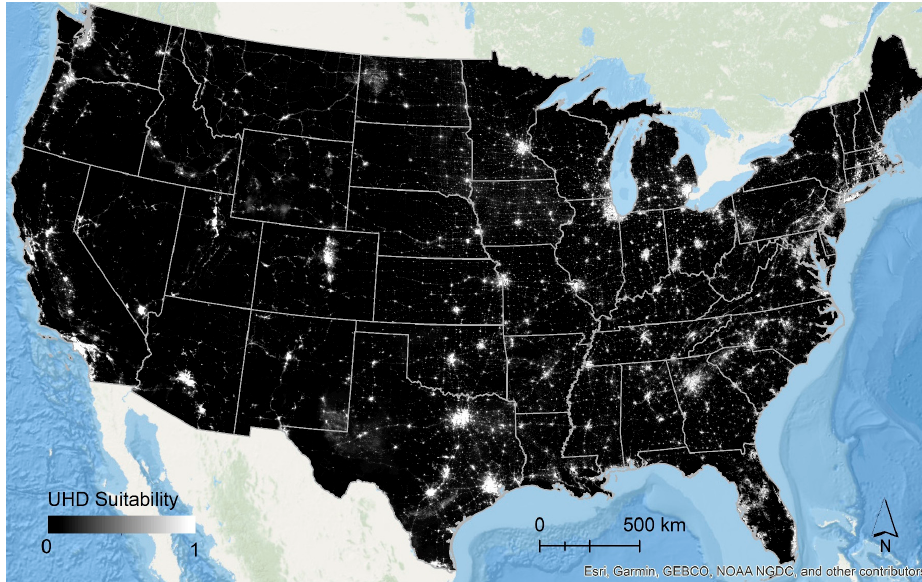
Figure 3. Overview of urban and highly developed (UHD) suitability. Table 1. Socioeconomic and physical variables used to estimate urban development